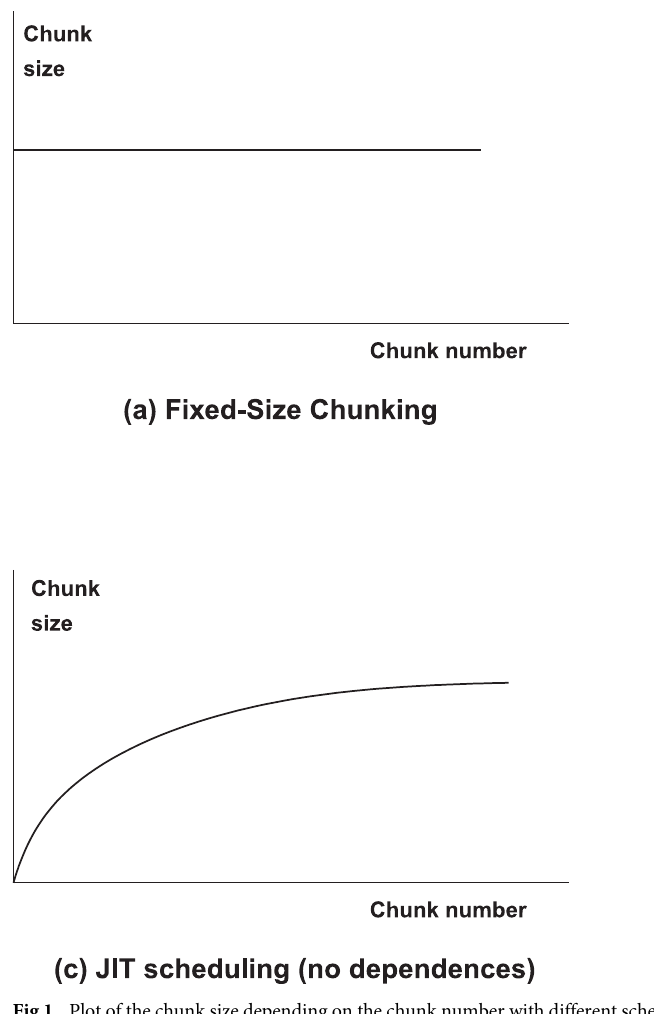
Fig 1. Plot of the chunk size depending on the chunk number with different scheduling strategies: (a) FSC, (b) M ESETA scheduling following the trapezoidal approach [20]. Finally, (c) and (d) show Just-In-Time scheduling in loops with and without dependencies,